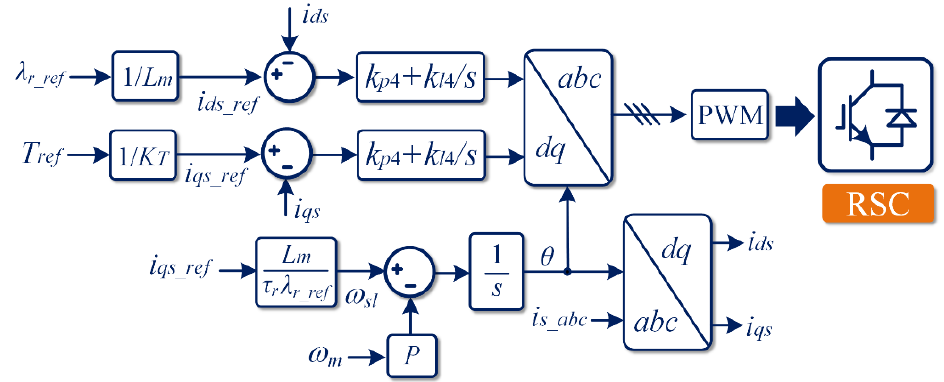
Figure 10. Control block diagram of the RSC.